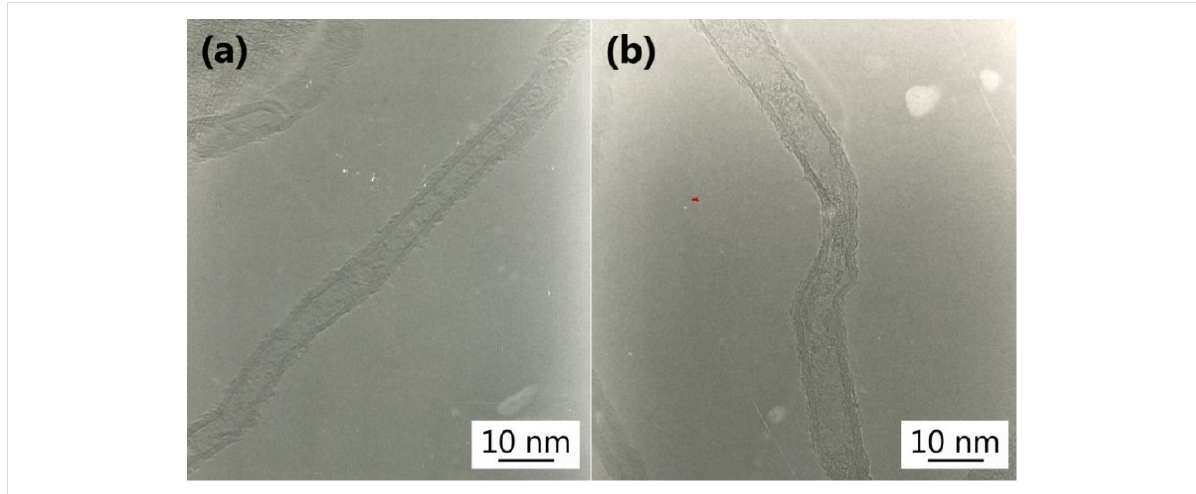
Figure 3: High resolution TEM images of the carbon nanotubes constituting the forests.